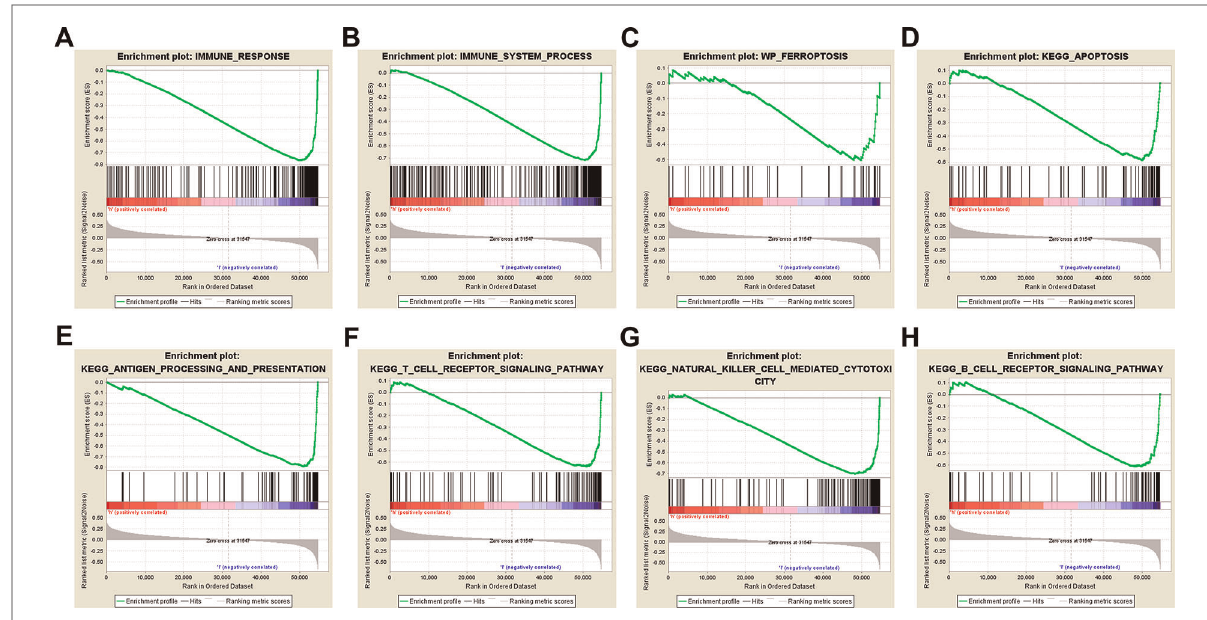
FIGURE 5 Gene set enrichment analysis. Immune-related and ferroptosis-related pathways were signi fi cantly enriched in the low-risk group. ( A ) Immune system process. ( B ) Immune response. ( C ) Ferroptosis. ( D ) Apoptosis. ( E ) Antigen processing and presentation. ( F ) T-cell receptor signaling pathway. ( G ) Natural killer cell-mediated cytotoxicity. ( H ) B-cell receptor signaling